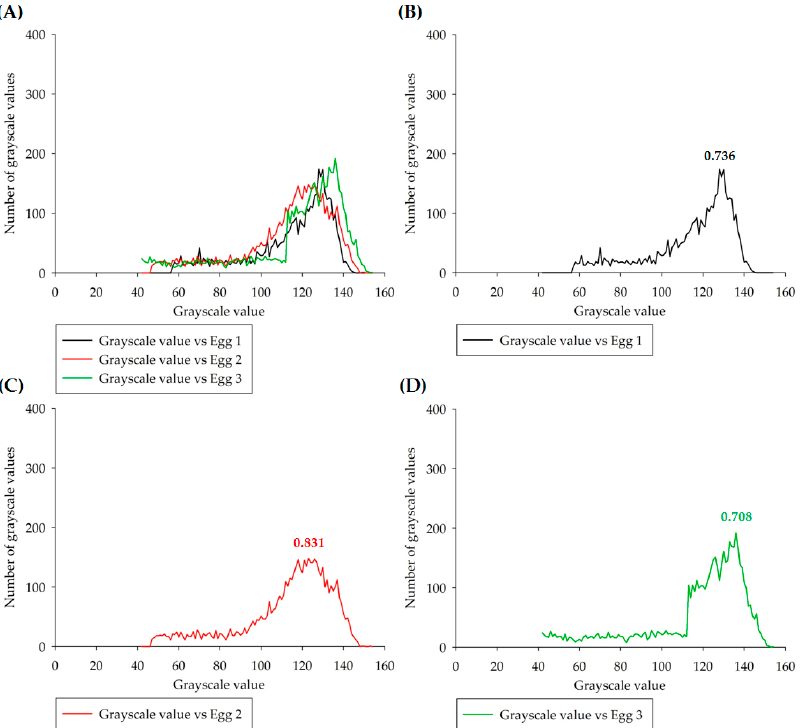
Figure 8. Analysis and statistics of the gray-scale density value distribution curve of the shells of eggs of three different qualities in the axial plane direction. ( A ) Comparison of shell quality curves of eggs of three different qualities, ( B ) SO egg (Egg 1) (black line), ( C ) GO egg (Egg 2) (red line), and ( D ) CO egg (Egg 3) (green line). After obtaining DICOM gray-scale images of the yolk and albumen of eggs of three different qualities in the median and axial plane directions, the results of the gray-scale density distribution analysis, and a comparison of the liquid structure of the yolk and albumen, which cannot be separated, are shown in Figures 9 and 10, respectively. Since the yolk is thicker than the albumen and its relative material density is also higher, cor- responding to the results of the inner egg stratification analysis of visualization in Figures 3C and 4C, the gray-scale value of yolk is greater than that of the albumen. Based on the analysis and statistics of the gray-scale value density curve, the peak value of the yolk is also higher than the peak value of the albumen. The graphs in Figures 9 and 10 show two different density peaks. Figure 9A shows a comparison of the inner egg part of the eggs of three different qualities. It shows that the gray-scale value distribution of the SO egg (Egg 1) is significantly larger than that of the GO egg (Egg 2) and the normal egg (Egg 3).